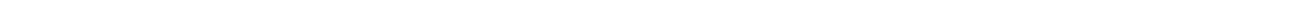
Fig. 7 Evidence for BRCAness in adult LMS. a Alterations in genes reported as synthetic lethal to PARP inhibition. Rows represent individual genes, columns represent individual tumors. Genes are sorted according to frequency of SNVs, indels, and CNAs (left). Bars depict the number of alterations for individual tumors (top) and genes (right). Types of alterations and treatment history are annotated according to the color codes (bottom). UTR untranslated region. b Contribution of mutational signatures to the overall mutational load in LMS tumors. Each bar represents the number of SNVs explained by the respective mutational signature in an individual tumor. Error bars represent 95% con fi dence intervals. AC Alexandrov-COSMIC. c Clonogenic assays showing dose- dependent sensitivity of LMS cell lines to continuous olaparib treatment (1 – 5 µ M ) with or without prior exposure to a 2-h pulse of cisplatin (5 µ M ).